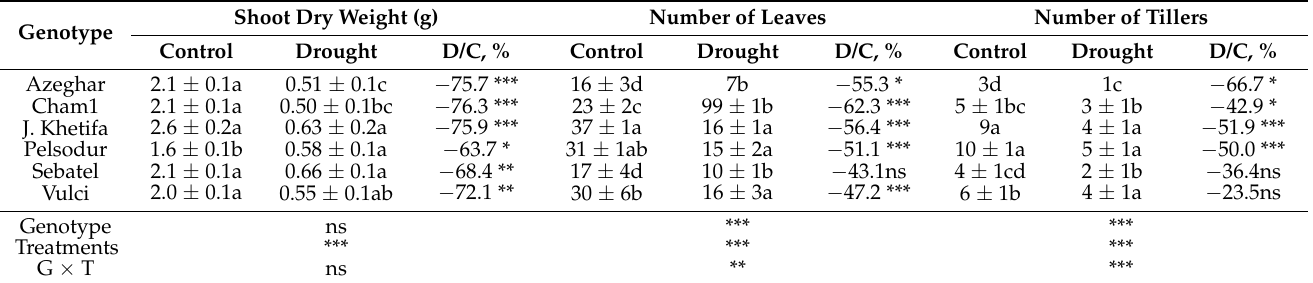
Table 1. Drought effect on shoot growth and development in greenhouse experiment. D/C—drought vs. control.